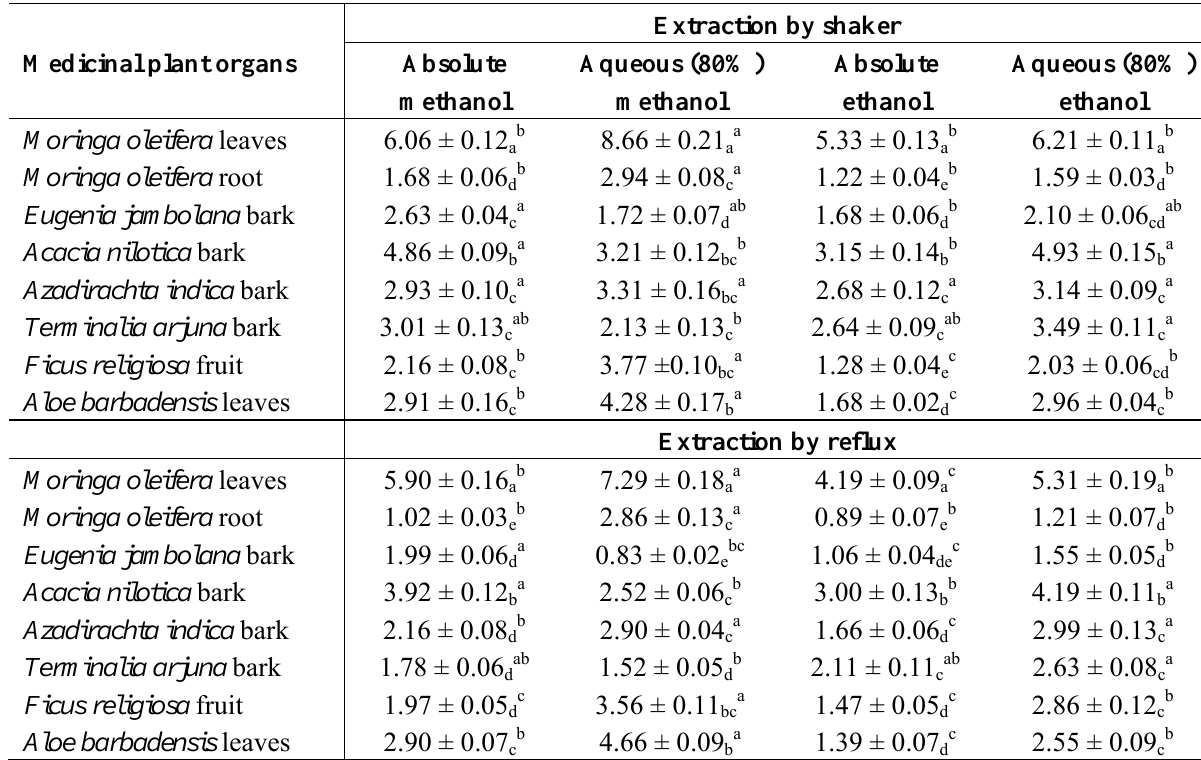
Table 3. Effects of extracting solvent/technique on the total flavonoid contents (CE g/100 g of DW) of medicinal plants